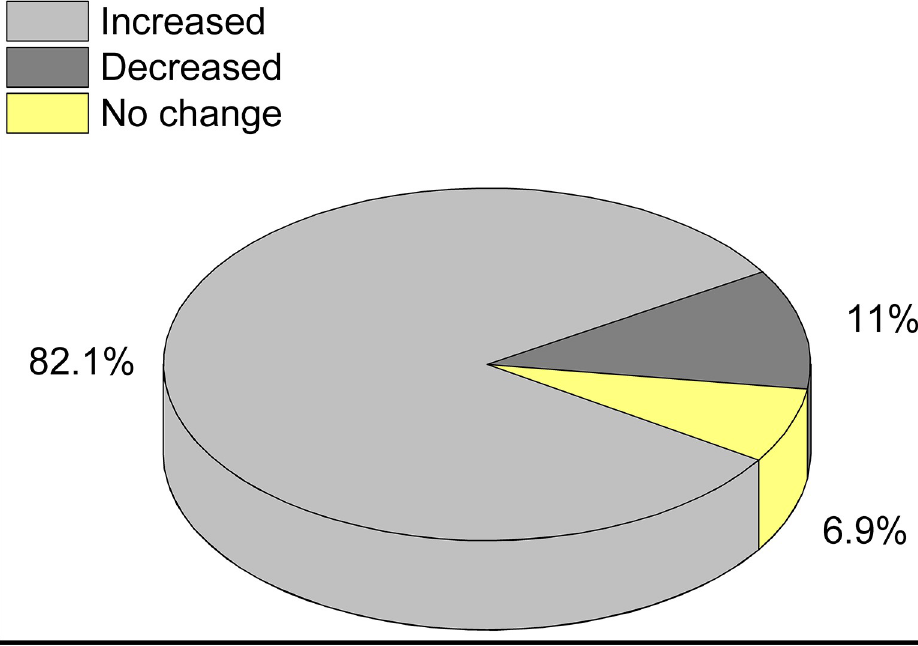
Fig 2. Multiple responses of households showing the current status of solid waste volume and composition in Gelemso town.